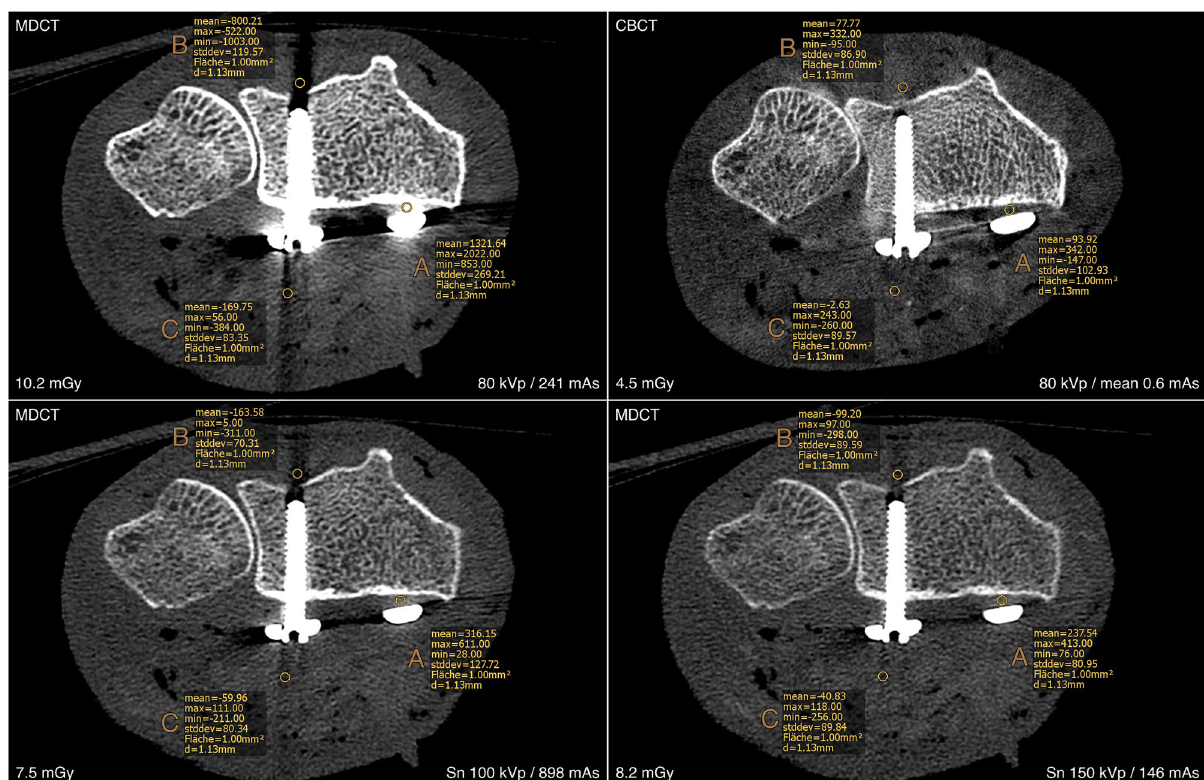
Figure 3. Region of interest (ROI) placement for objective assessment of metal artifact intensity. Note—A = hyperdense artifacts; B = hypodense artifacts; C = artifact-impaired soft